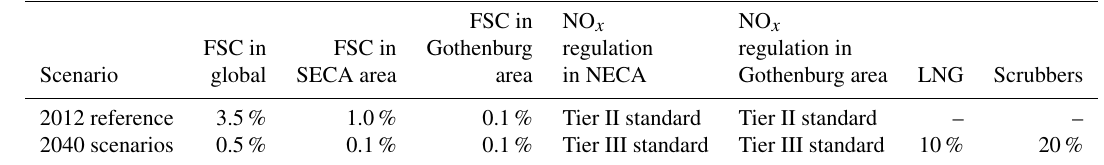
Table 1. Major regulation changes for the different scenarios.